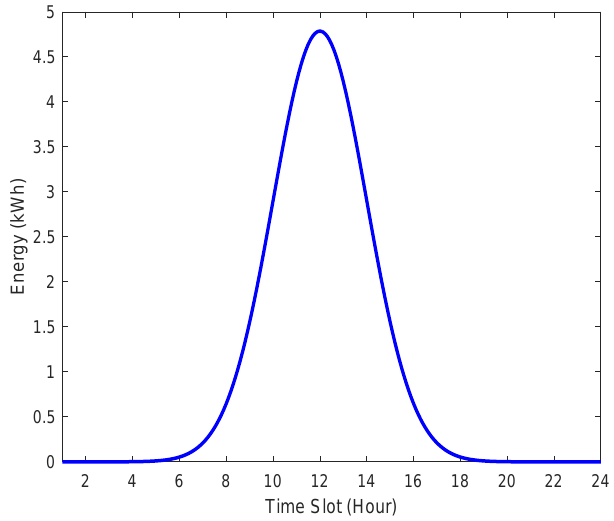
Figure 3. Electricity output curve according to PV power generation.